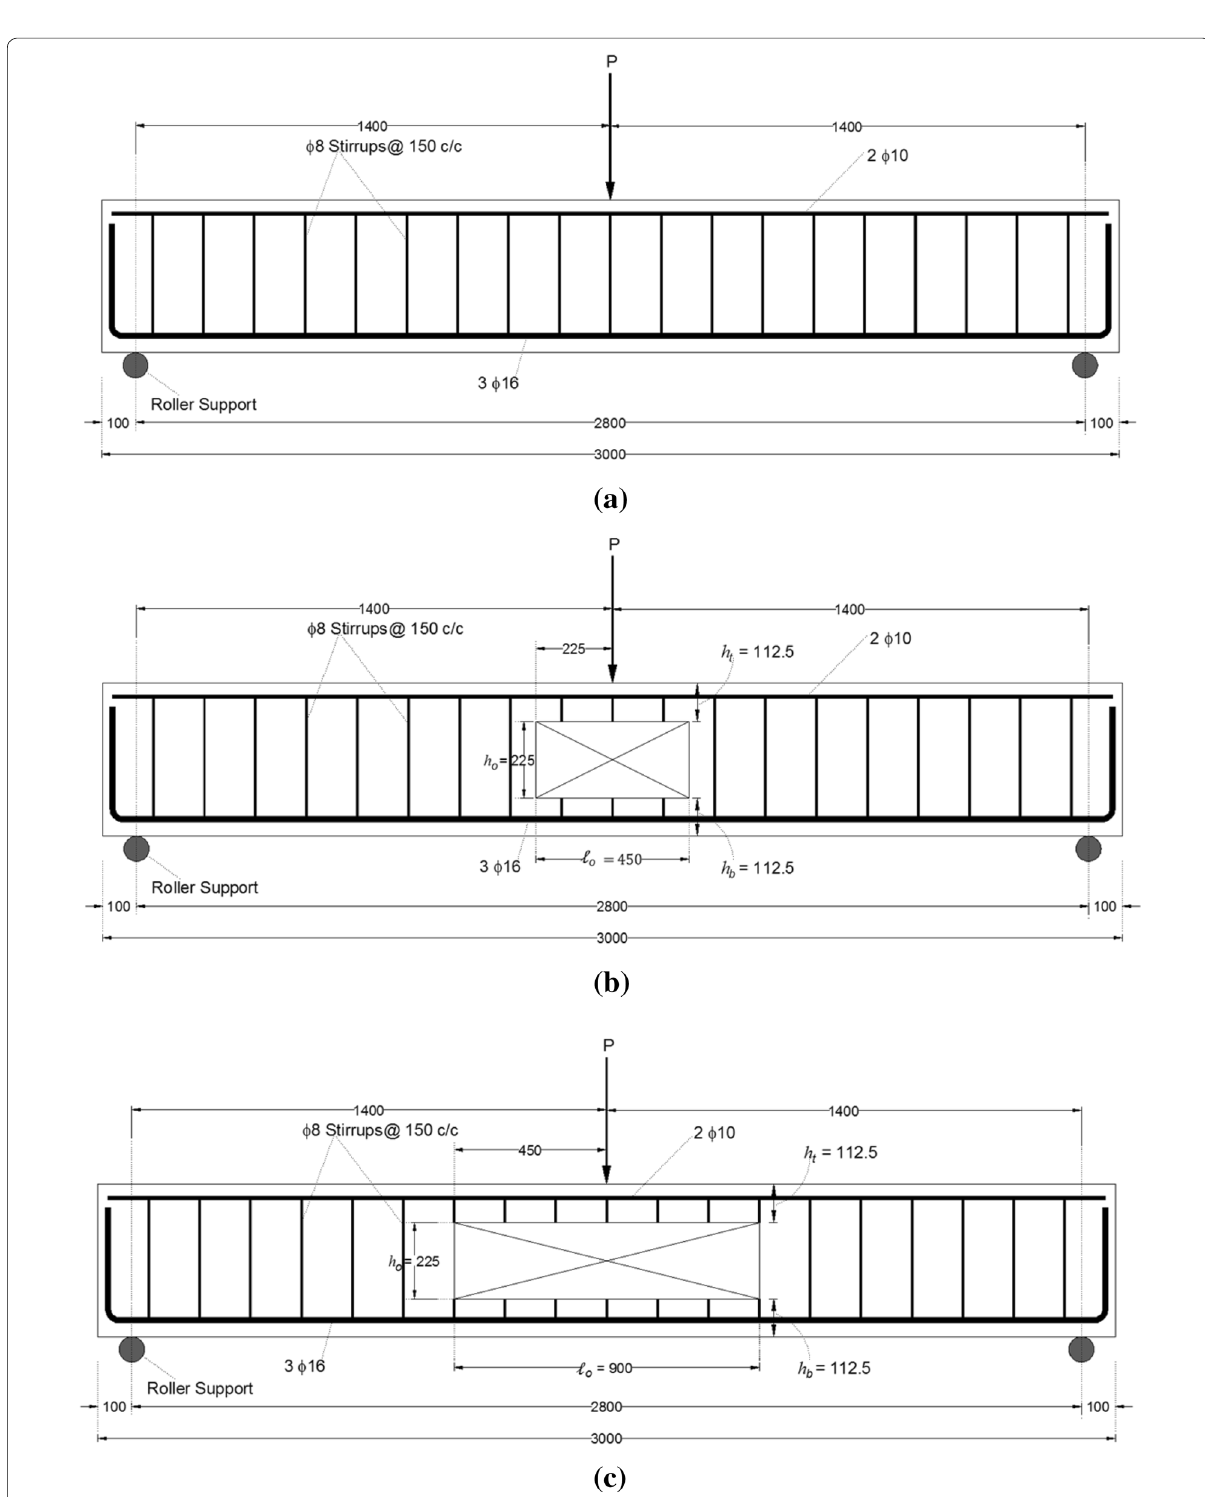
Fig. 3 Details of unstrengthened beams with center‑point loading (Note: all dimensions are in mm): a elevation of beam BC‑N‑CPL, b elevation of beam BC‑O1‑CPL, and c elevation of beam